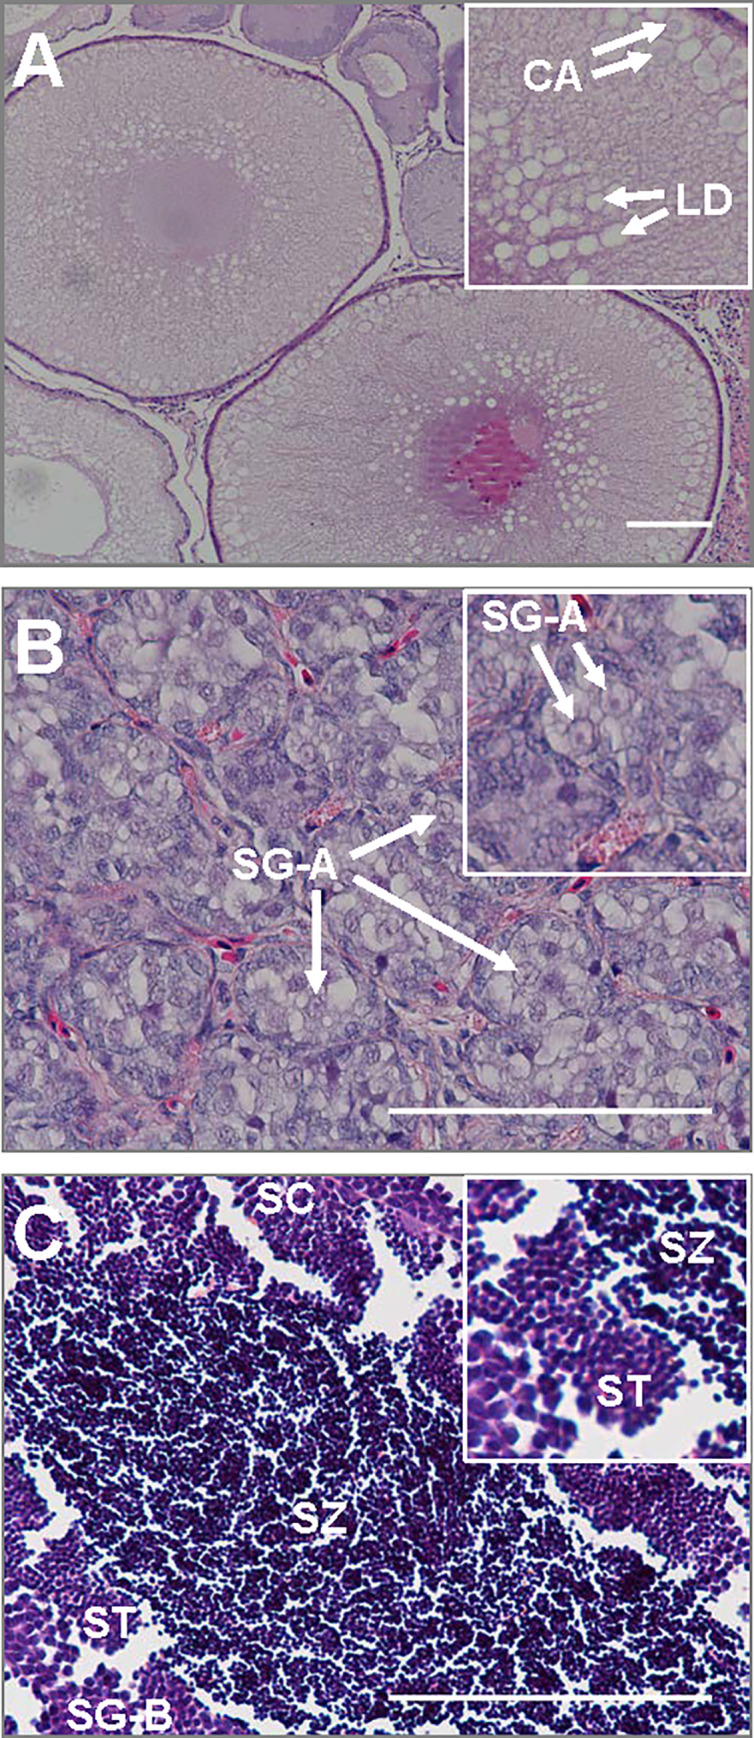
Representative histological sections of gonads sampled from Atlantic salmon (Salmo salar) farmed at Nordlaks AS (Norway).Shown are immature ovaries of a female (A), and immature testes (B) and sexually maturing testes of males (C) with higher magnification insets in each. Cortical alveoli (CA); early lipid droplets (LD); type-A spermatogonia (SG-A); type-B spermatogonia (SG-B); spermatocytes (SC); spermatids (ST); spermatozoa (SZ). Scale bars are 100 μm in main images; higher magnification inset widths are 150 μm for panel A and 50 μm for panels B & C.